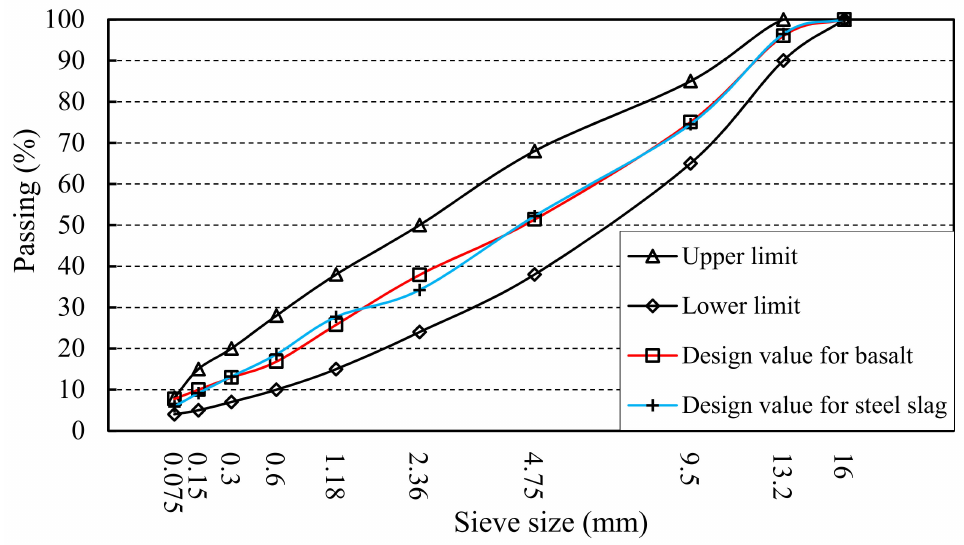
Figure 2. Aggregate gradation curve of